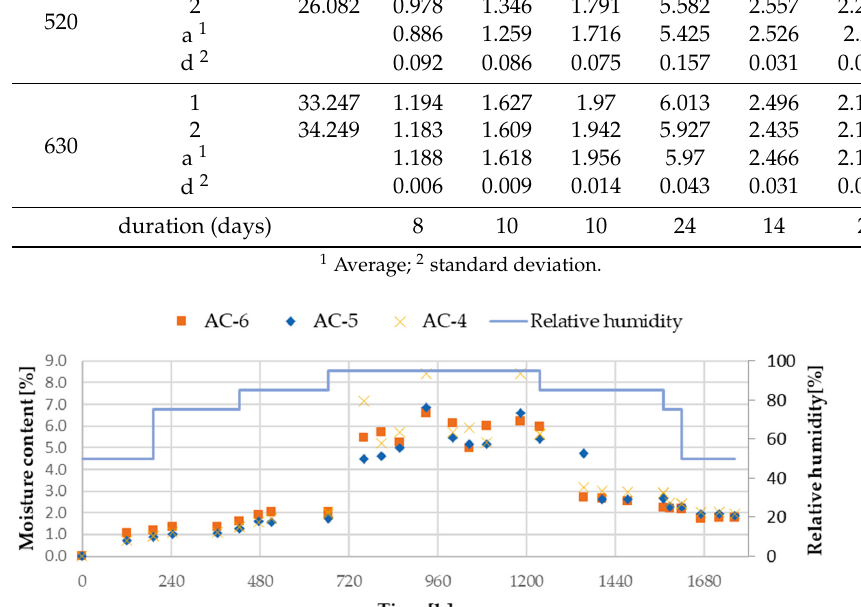
Figure 6. Moisture content of the samples in the environmental chambers.